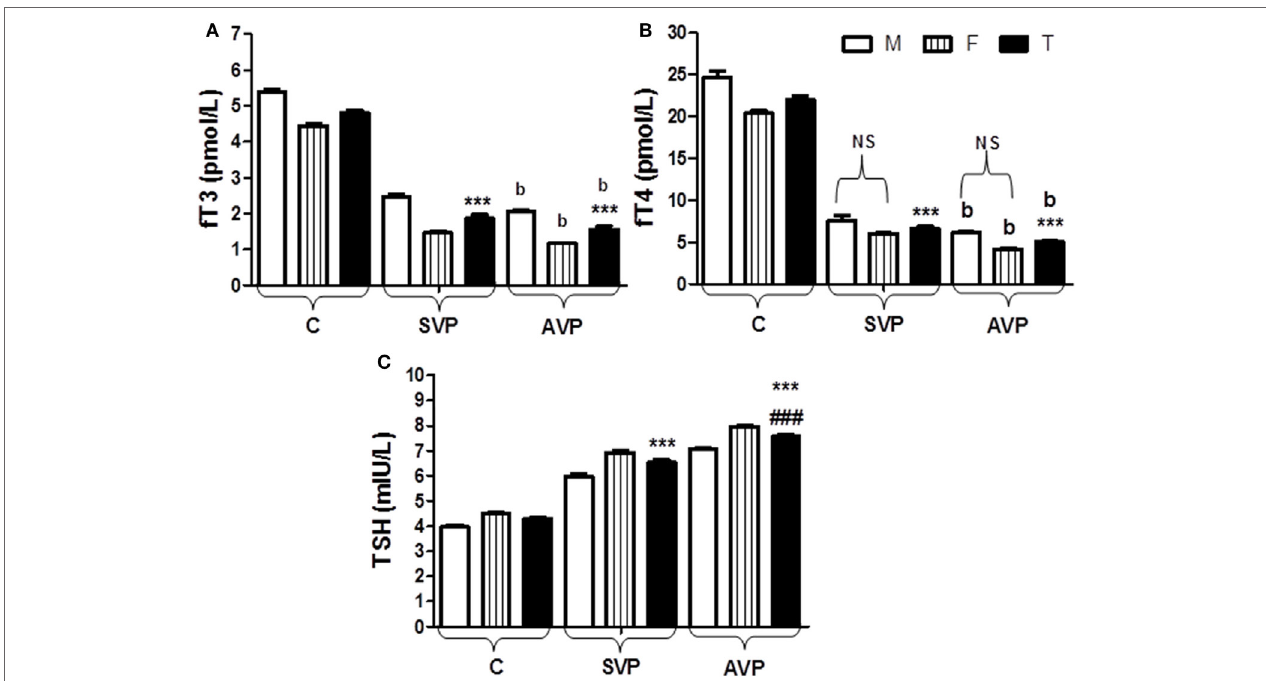
FigUre 4 | Serum levels of fT 3 (a) , fT 4 (B) , and TSH (c) in vitiligo patients compared with control subjects. Values expressed as mean ± SEM. *** p < 0.001 significant vs. Control. ### p < 0.001 significant vs. SVP, b; non-significant vs. SVP (between groups Total vs. Total; Male vs. Male; Female vs. Female). NS is a non-significant within group (Male vs. Female). Abbreviations: C, control; SVP, stable vitiligo patient; AVP, active vitiligo patient; M, male; F, female; T, total; fT 3 , free triiodothyronine; fT 4 , free thyroxine; TSH, thyroid-stimulating hormone.